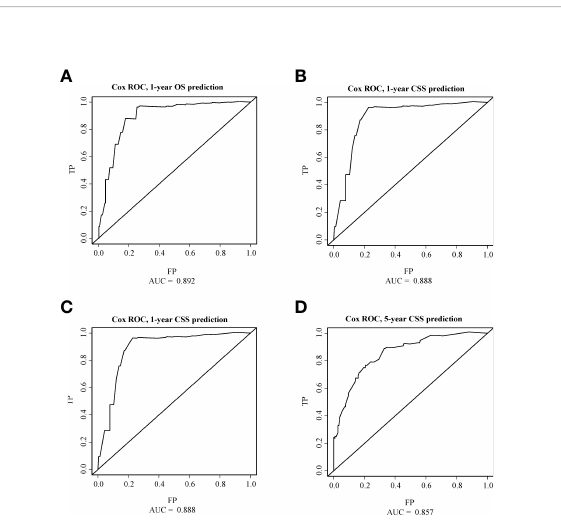
FIGURE 6 ROC curves of OS and CSS. (A) The ROC curve of 1-year OS; (B) The ROC curve of 5-year OS; (C) The ROC curve of 1-year CSS; (D) The ROC curve of 5-year CSS.